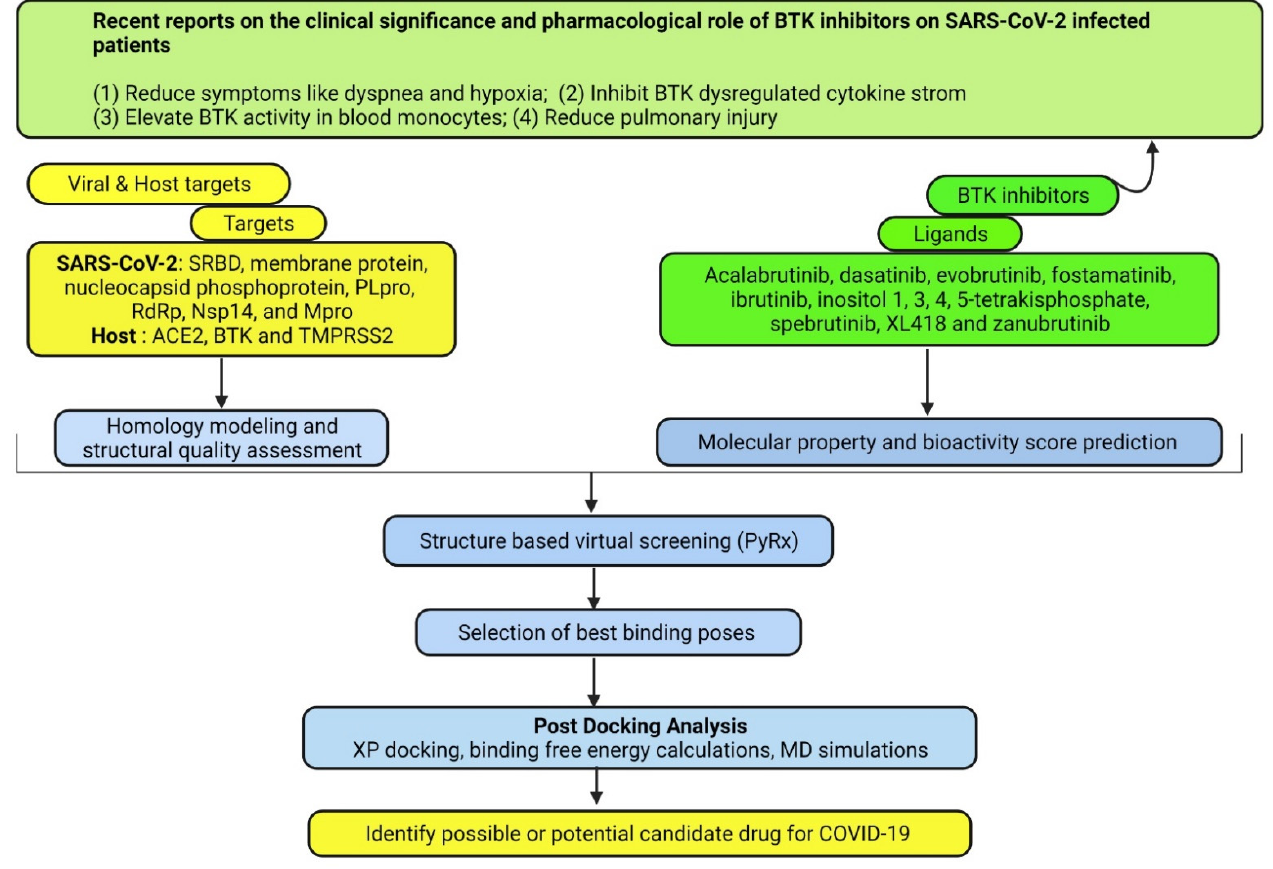
Figure 1. Overview and workflow of this study. ACE2—angiotensin-converting enzyme 2; BTK—Bruton’s tyrosine kinase; MD—molecular dynamics; Mpro—main protease; nsp—nonstructural protein; PLpro—papain-like protease; RdRp—RNA-dependent RNA polymerase (RdRp), SRBD—spike receptor-binding domain; TMPRSS2—transmembrane serine protease 2.